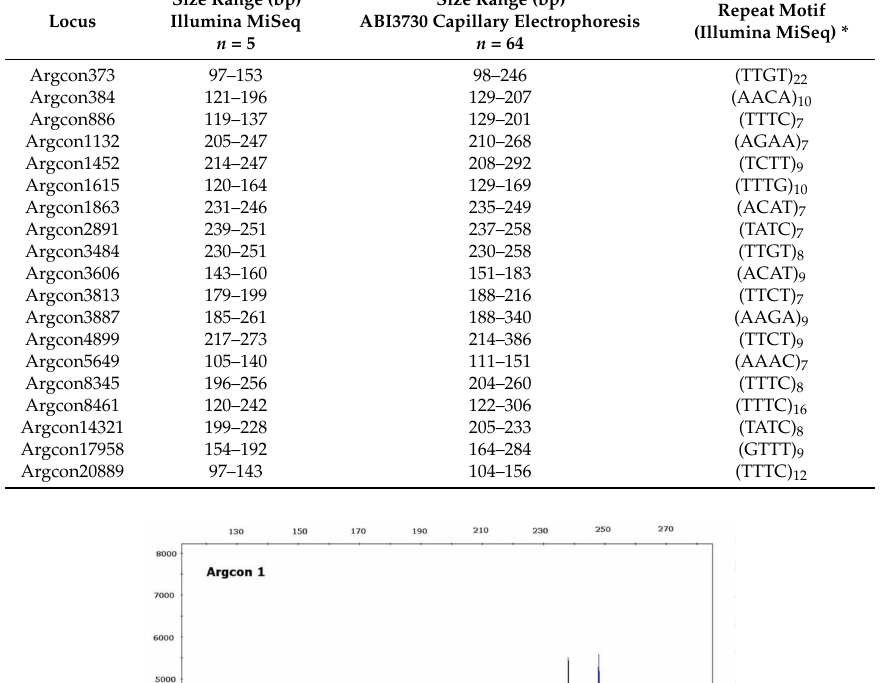
Table 1. Overview of the 19 tetranucleotide short tandem repeats (STRs) identified in the apple fruit moth ( Argyresthia conjugella ). Asterisk = number of repeats from sequencing. Size Range (bp) Locus Illumina MiSeq